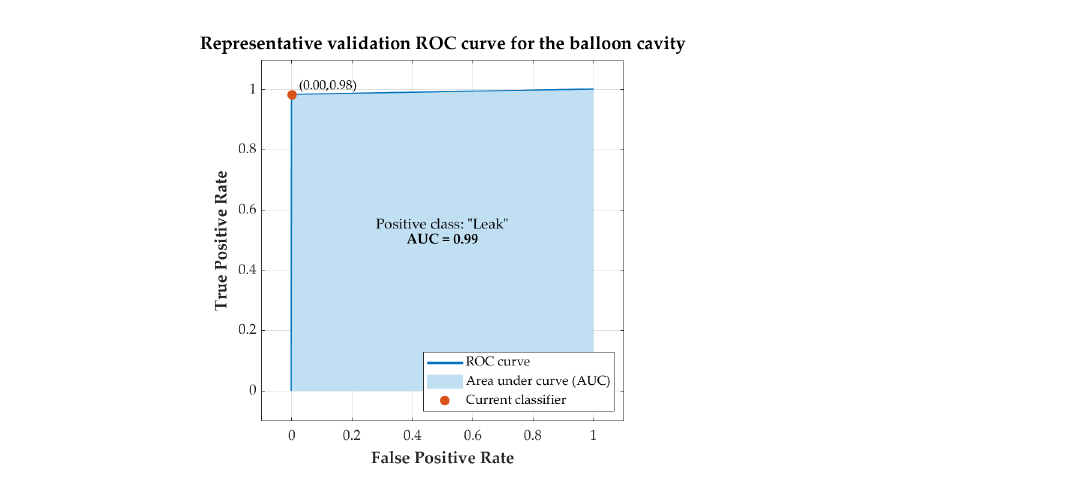
Figure 7. Representative validation ROC curve obtained for the balloon cavity model with median tree algorithm with input features a 4 , a 6 , and a 7 .